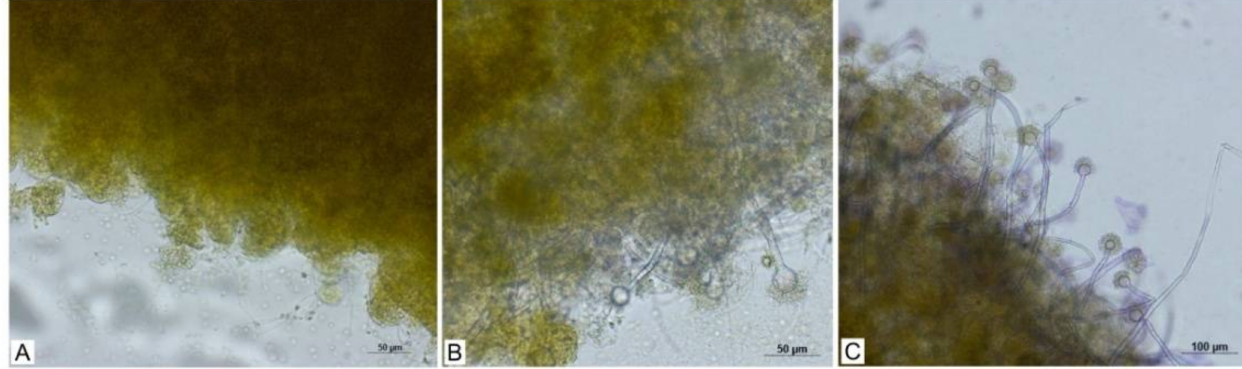
Figure 4. Visual results of biocoagulation. Pellets of A. niger ( A ), cells of the algae Chlorella sp. ( B ), results after 24 h ( C ), results after 48